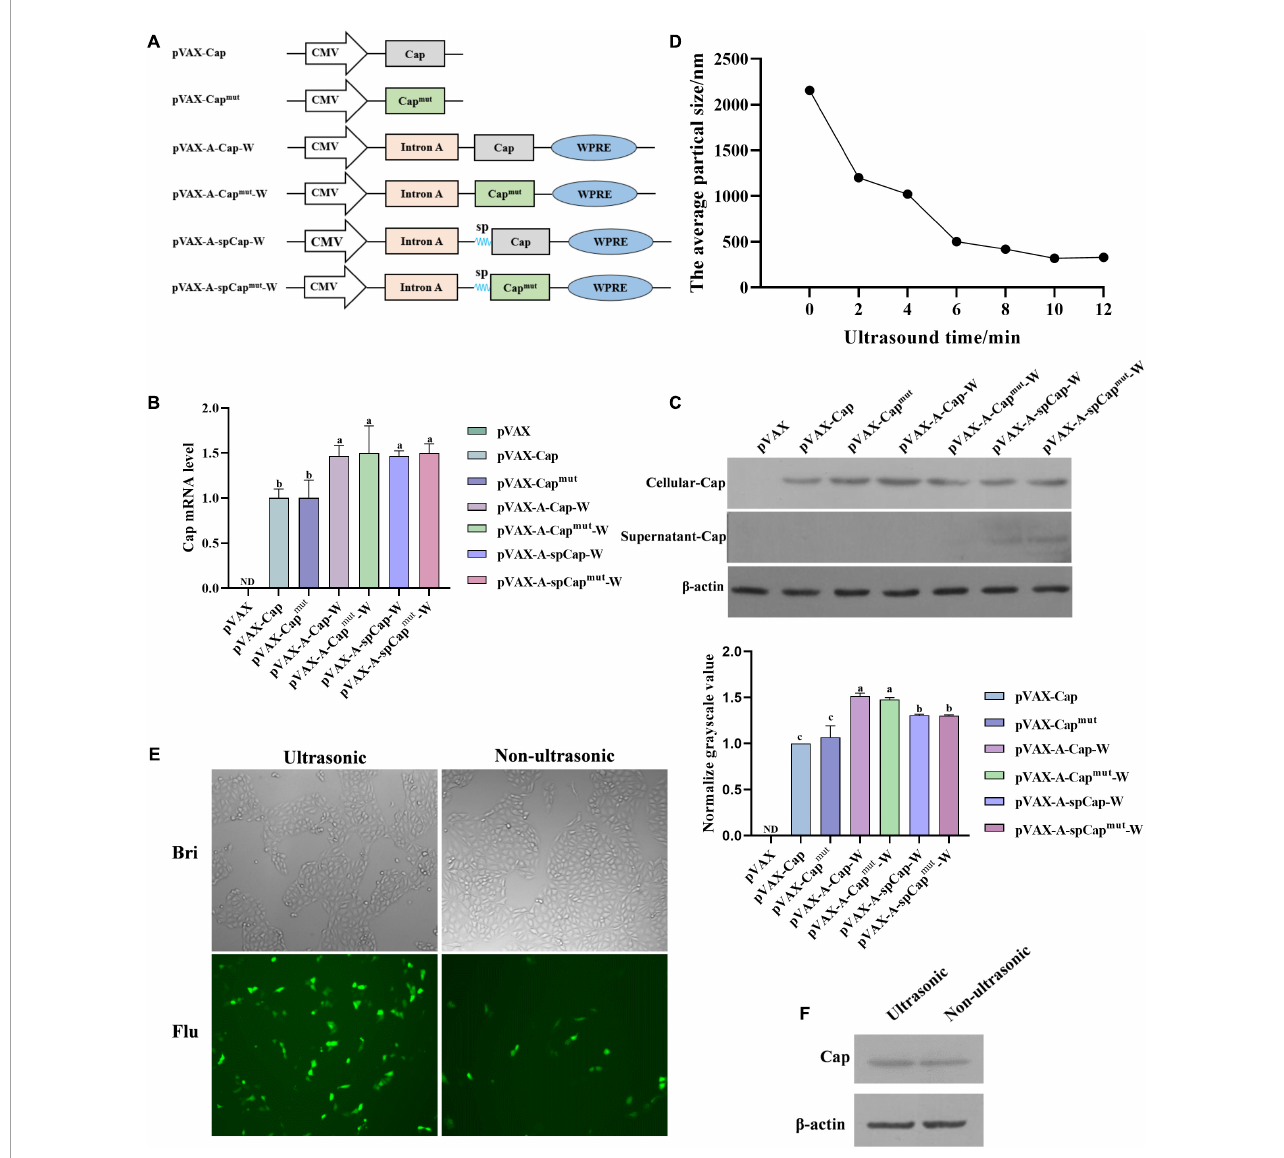
FIGURE1 Construction of the plasmids and preparation of the porcine circovirus type 2 (PCV2) DNA vaccines. (A) Shematic structure of pVAX-Cap, pVAX-Cap mut , pVAX-A-Cap-W, pVAX-A-Cap mut -W, pVAX-A-spCap-W, pVAX-A-spCap mut -W, and the plasmids expressing CXCL12, CCL22, and CCL25. Human cytomegalovirus (CMV) represents the promoter of the vectors, sp represents the IL-2 secretory signal peptides. (B) The pVAX-Cap, pVAX-Cap mut , pVAX-A-Cap-W, pVAX-A-Cap mut -W, pVAX-A-spCap-W, and pVAX-A-spCap mut -W plasmids were transfected into 293T cells with equal amount for 48 h, then the mRNA levels of Cap were measured by qPCR. (C) The pVAX-Cap, pVAX-Cap mut , pVAX-A-Cap-W, pVAX-A-Cap mut -W, pVAX-A-spCap-W, and pVAX-A-spCap mut -W plasmids were transfected into 293T cells with equal amount for 48 h, the expression levels of Cap in the transfected cells and in the supernatants of these cells were examined by western blot. (D) The polyethylenimine (PEI) containing plasmids were treated with ultrasonic for 2, 4, 6, 8, 10, and 12 min, respectively. The particle sizes of the treated mixtures were analyzed. (E,F) The ultrasonic PEI containing pVAX-Cap and 1/10 pEGFP-N1 and the non-ultrasonic PEI containing pVAX-Cap and 1/10 pEGFP-N1 were transfected into PK-15 cells for 48 h, the transfection efficiency was analyzed by fluorescence microscopy (E) and western blot (F) . ND means not detected, the same small letters (a and b) represent no significant difference among the groups, and different small letters represent significant differences among the groups in (B)